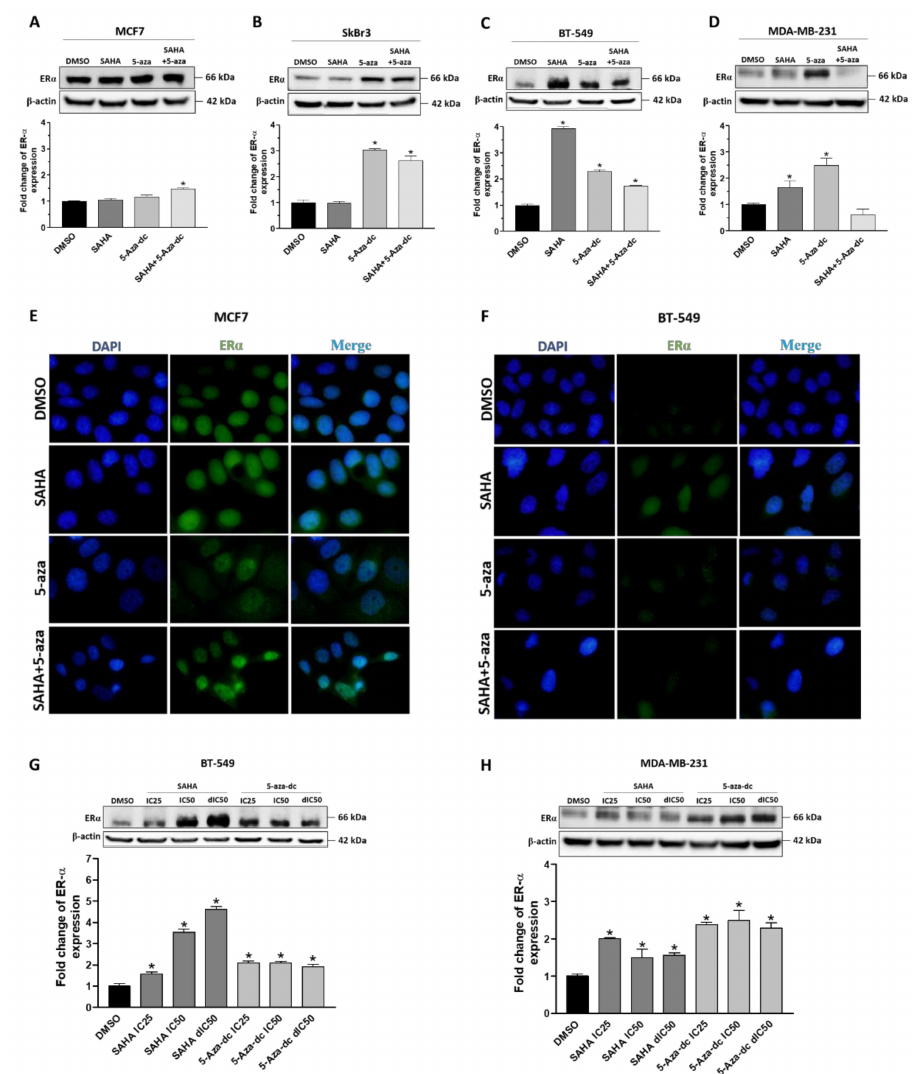
Figure 4. Effect of SAHA, 5-aza-dc and their combination on the expression of ER α in breast cancer cells. ( A – D ) Upper panels: Western blot analysis of ER α expression in ( A ) MCF7, ( B ) SkBr3, ( C ) BT549 and ( D ) MDA-MB-231 cells treated with the IC50 concentrations of SAHA and/or 5-aza-dc. Lower panel: Bar graphs showing relative fold changes of ER α bands after quantification and normalization to β -actin expression and DMSO treatment. ( E , F ) Representative micrographs (at 100 × magnification) of immunofluorescence staining of ER α (green) and 4 (cid:48) ,6-diamidino-2-phenylindole (DAPI)(blue) in ( E ) MCF7 and ( F ) BT-549 cells treated with SAHA and/or 5-aza-dc. ( G , F ) Western blots of ER α expression in ( G ) BT-549 and ( H ) MDA-MB-231 cells treated with IC25, IC50, and double IC50 (dIC50) concentrations of SAHA or 5-aza-dc. Shown are the means ± SEM of at least three independent experiments. * p < 0.05 versus DMSO